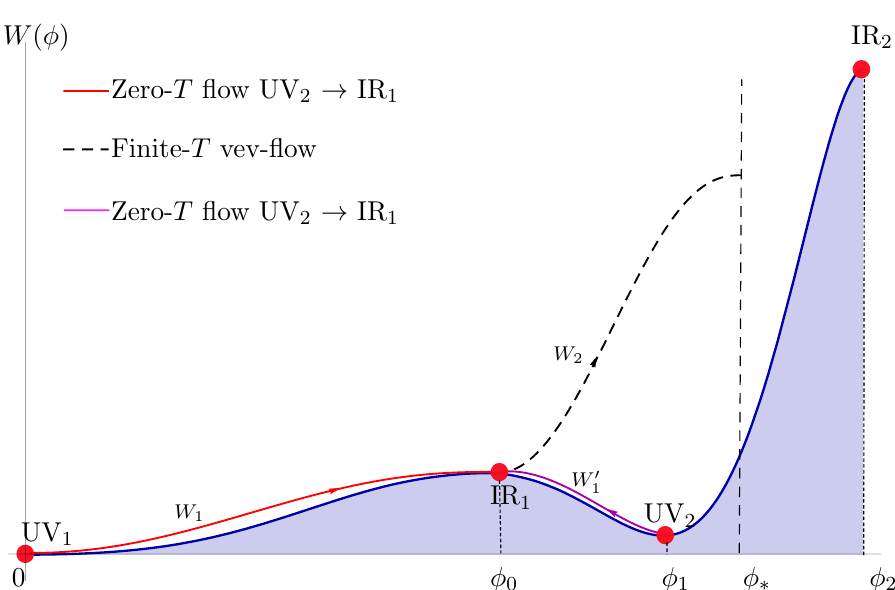
Figure 17 . In the limit (cid:30) h ! (cid:30) (cid:3) the solutions reduce to the two zero-temperature (cid:13)ows ending at IR 1 , plus a (cid:12)nite-temperature (cid:13)ow starting at IR 1 in the UV and having its horizon at (cid:30) = (cid:30) (cid:3) (dashed black curve). This solution has a (cid:12)nite temperature and entropy since it has a regular black-hole